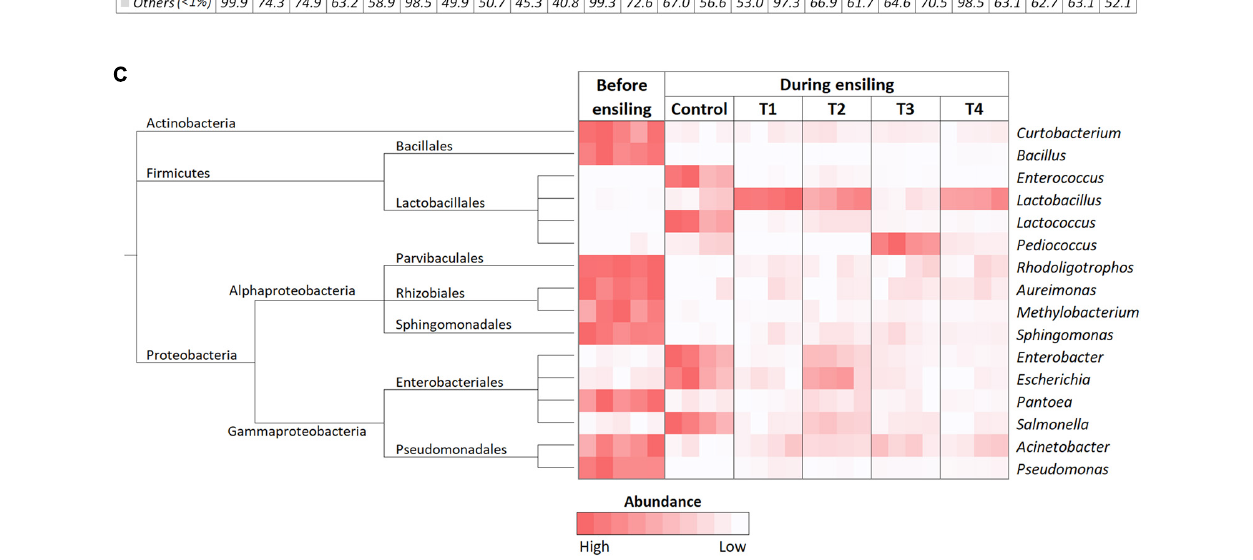
Frontiers in Microbiology |